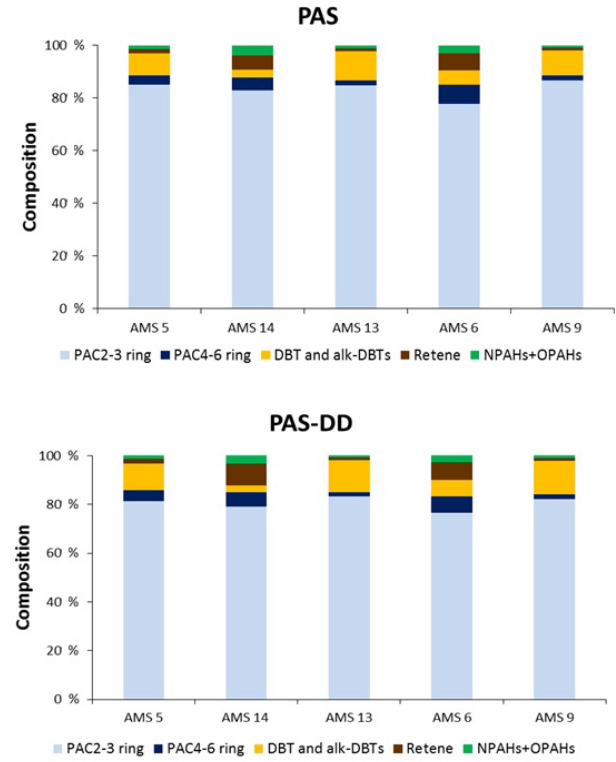
Figure 2. Composition of target compounds in air samples from five sites in the oil sands region, collected using the conventional passive sampler (PAS) and the passive dry deposition sampler (PAS- DD), collected during October to November 2015. “PAC” includes parent PAHs and